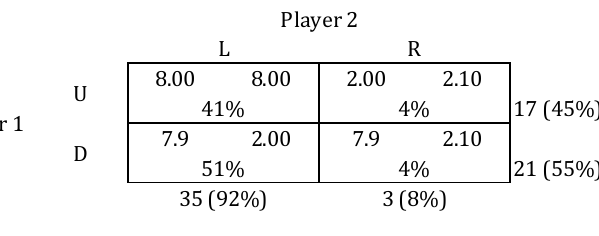
Figure 1. The Stag Hunt